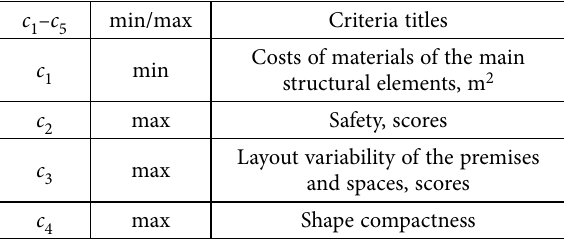
– c ) sorted by relevance 1 5